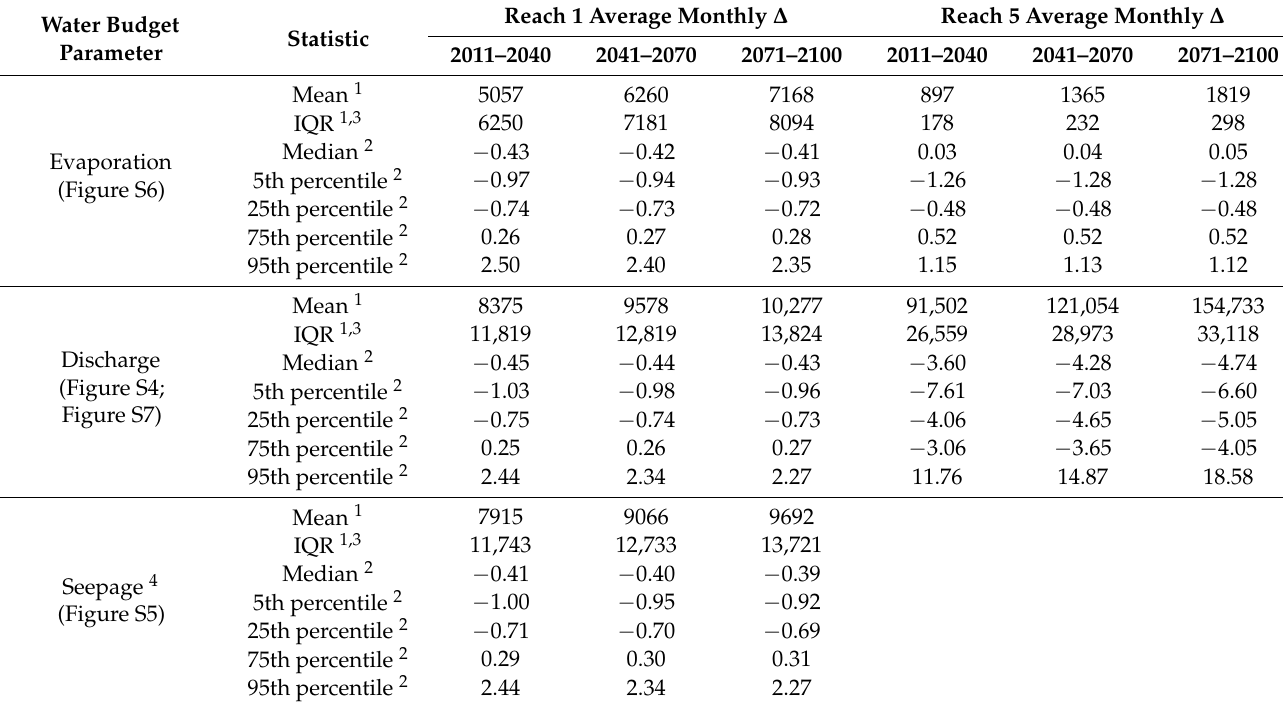
Table 4. CC Scenario Water Budget Component Results for Reach 1 and